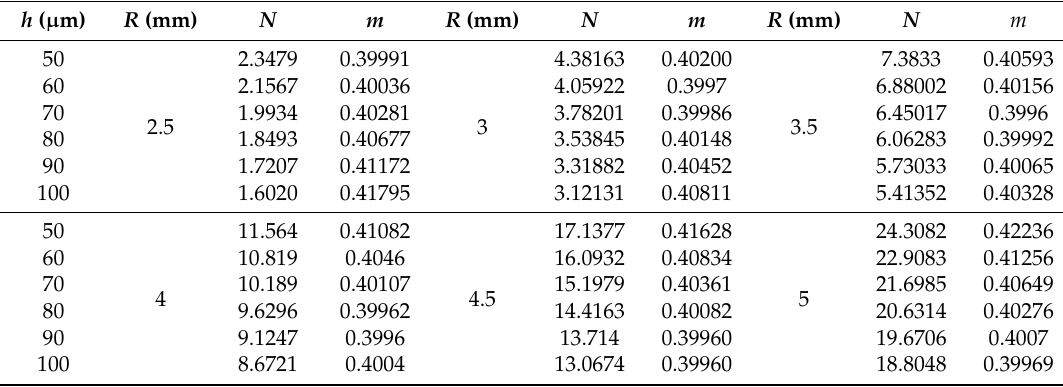
Table 1. The value of the parameters m and N with different R and different thickness h